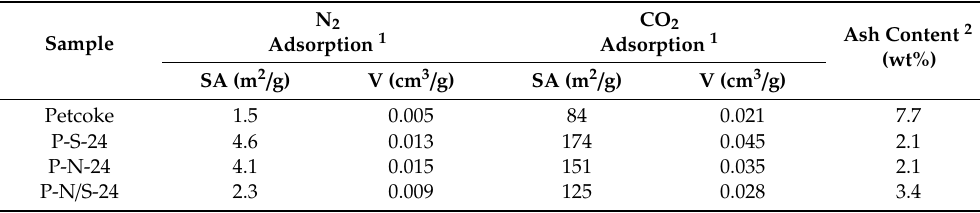
Table 2. Physical properties of petcoke before and after various acid treatments.